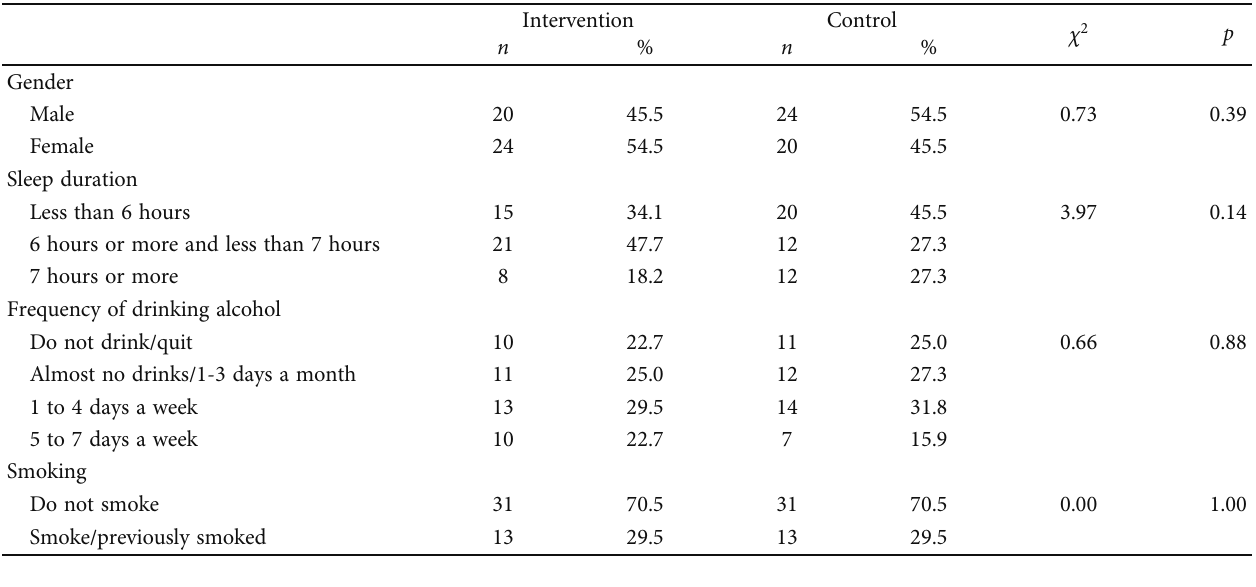
Table 1: Demographics of subjects at